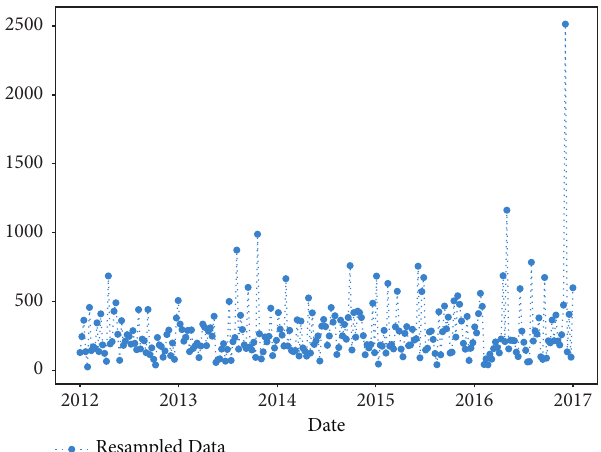
Figure 6: Distribution of downsampled demand data.